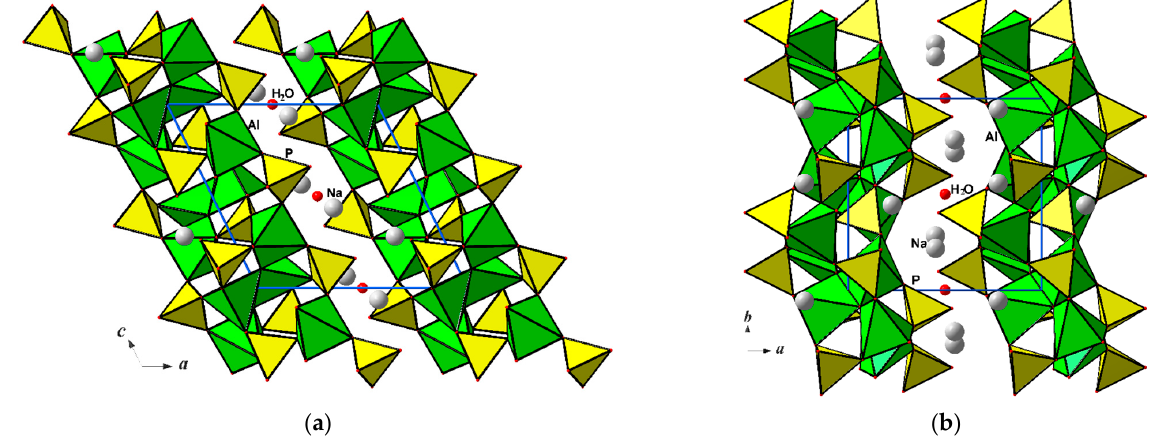
Figure 3. The Na 2 Al 2 O(PO 4 ) 2 ·0.12H 2 O crystal structure displayed in xz ( a ) and xy ( b ) projections.